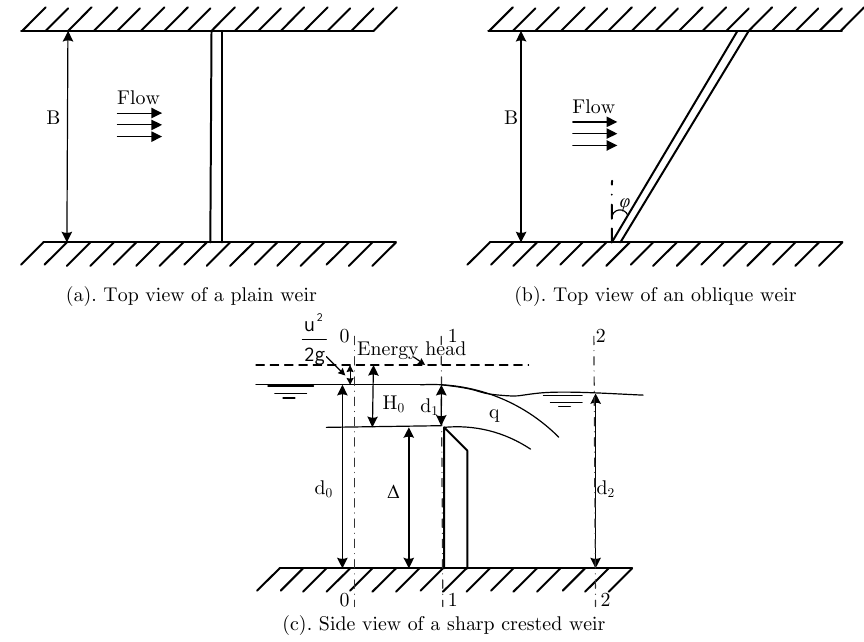
Fig. 1. Plane and side views of the